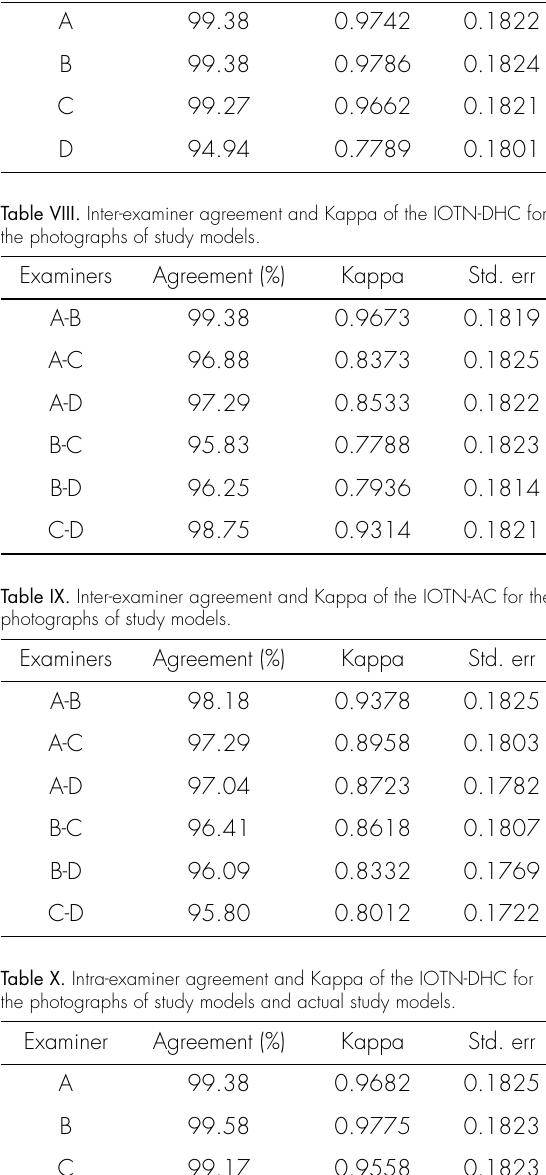
Table VII. Intra-examiner agreement and Kappa of the IOTN-AC for the photographs of study models. Examiner